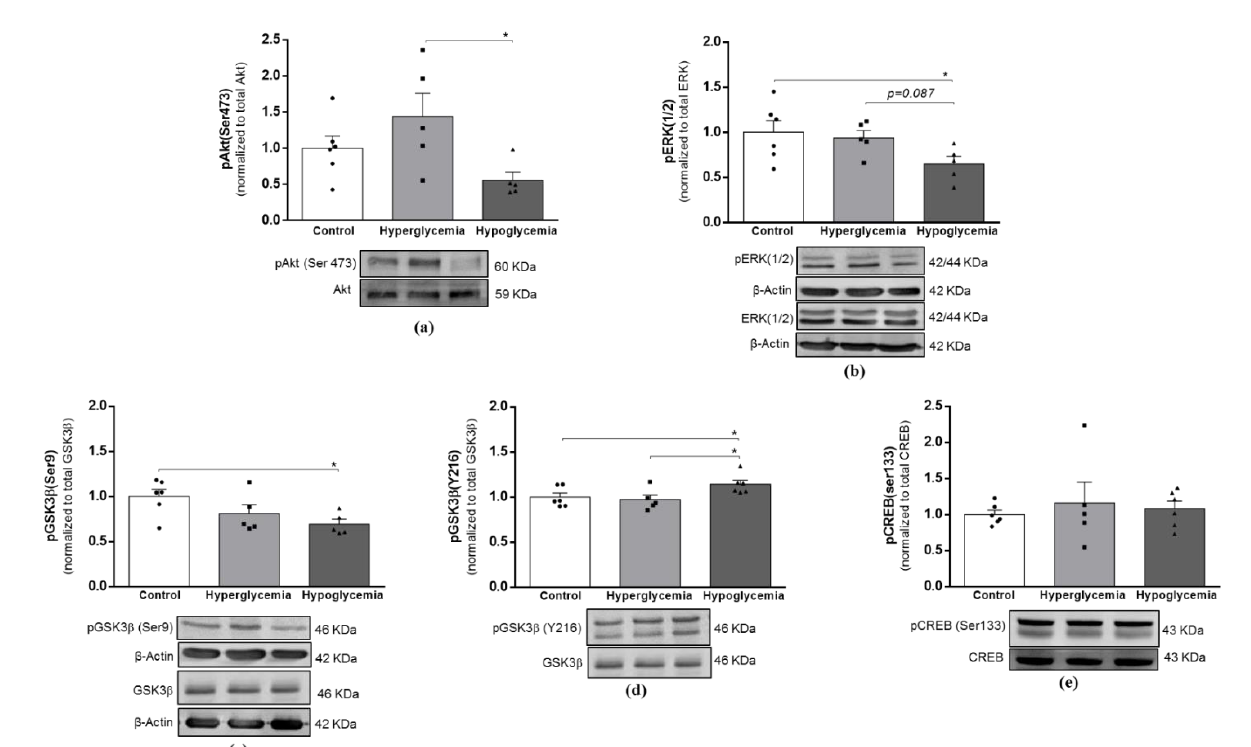
Figure 7. Effects of long-term hyperglycemia and insulin-induced recurrent hypoglycemia on insulin-mediated downstream signaling pathways. Western blot analyses of the ratio of ( a ) pAkt/total Akt, ( b ) pERK/total ERK, ( c ) pGSK3β(Ser9)/total GSK3β, ( d ) pGSK3β(Y216)/total GSK3β and ( e ) pCREB(Ser133)/total CREB. Graphs show mean ± SEM of the quantification of brain cortical samples from 5-6 rats under each condition normalized to control animals. Representative immunoblots are shown below the graphs (for uncropped images of the Western blots, please see Supplementary Data). * p < 0.05 was considered as a statistically significant difference. (p)ERK—(phosphorylated) extracellular signal-regulated kinase; (p) GSK3β—(phosphorylated) glycogen synthase kinase 3β; (p) CREB—(phosphorylated) cAMP-response element binding protein.